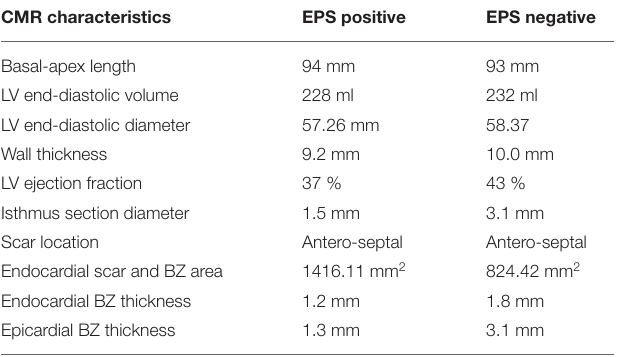
TABLE 2 | Cardiovascular magnetic resonance (CMR) features of the two